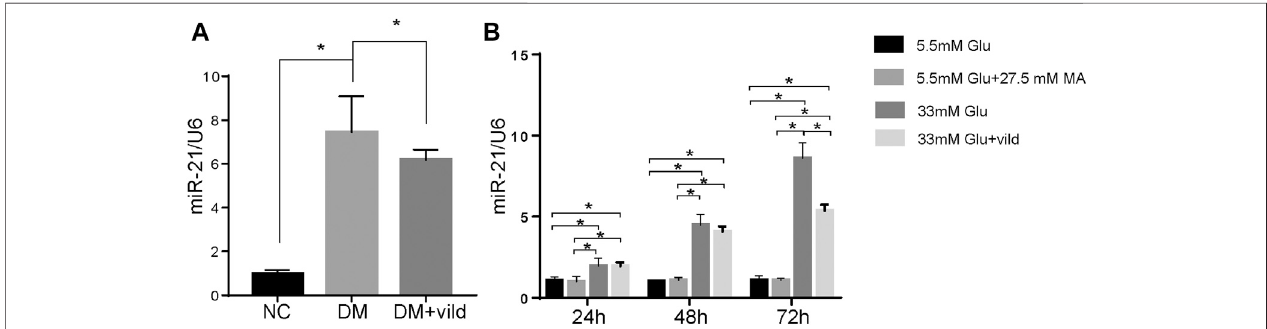
FIGURE 3 | miR-21 is upregulated in diabetic cardiomyopathy. (A) Expression of miR-21 of each group in tissues. (B) Expression of miR-21 in different groups of H9c2 cells. miR-21 expression level is expressed relative to that of U6 snRNA. Error bars represent SEM. * p < 0.05.